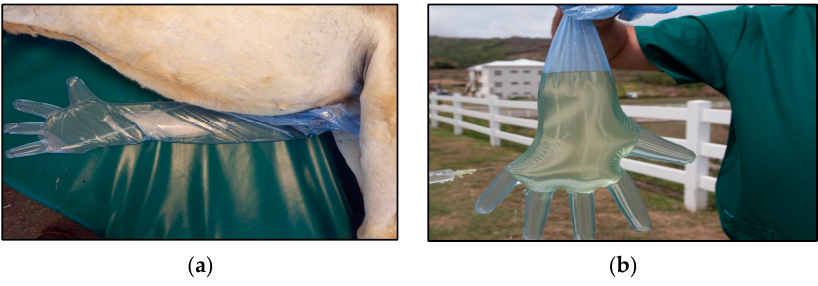
Figure 1. ( a ) Donkey under general anesthesia with palpation glove to collect urine; ( b ) Aspiration of urine sample into sterile syringe for collection.